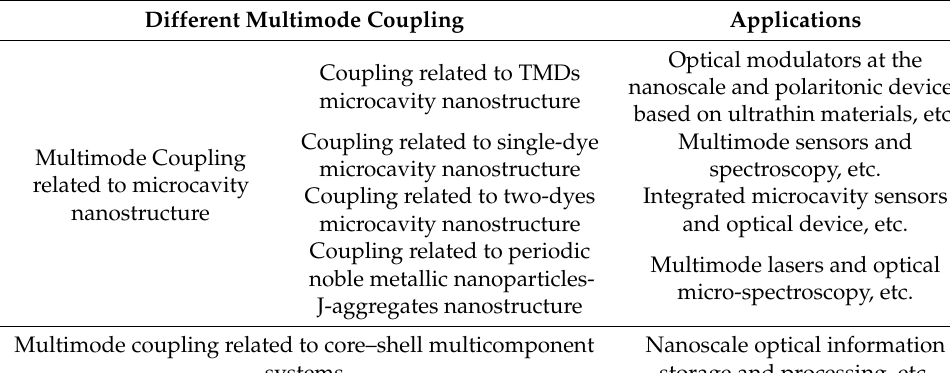
Optical modulators at the nanoscale and polaritonic devices based on ultrathin materials, etc. Multimode sensors and spectroscopy, etc. Integrated microcavity sensors and optical device, etc. Multimode lasers and optical micro-spectroscopy, etc. Nanoscale optical information storage and processing,